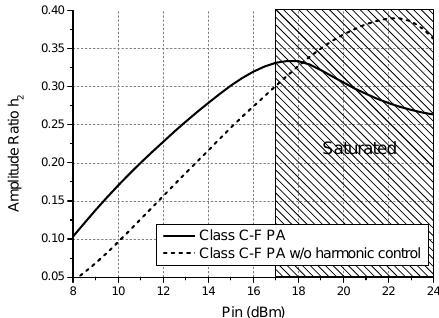
Figure 10. The simulated harmonic amplitude ratio between 2nd harmonic and fundamental frequency at gate